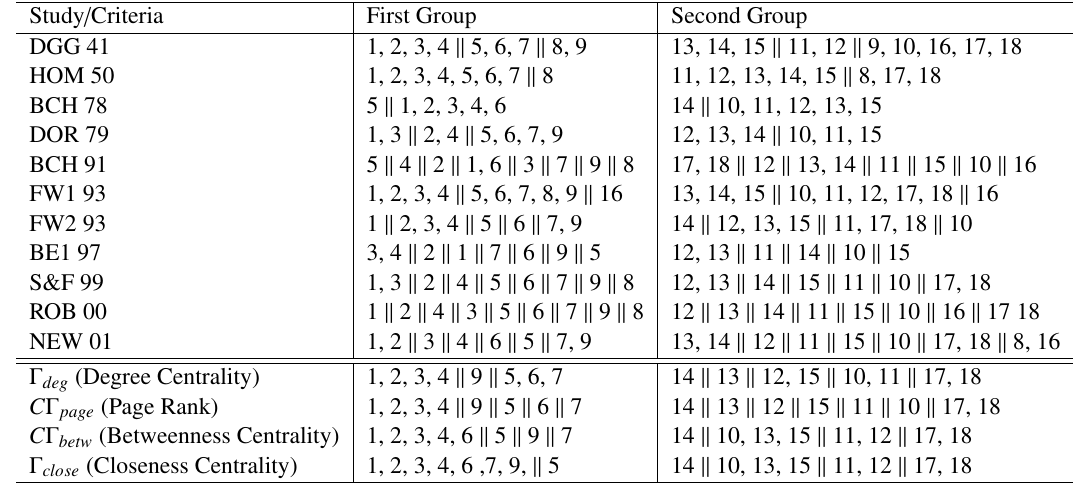
Table 1 The core & periphery membership assignments of the women in the DGG network from 11 di ff erent studies are shown above (see the survey [13]). The rankings are from left to right where di ff erent core and peripheral levels are separated by (cid:107) in each study and the women are represented by their subscripts. The last four rows show the hierarchy obtained for the first and second groups G 1 = { W 1 – W 7 , W 9 } and G 2 = { W 10 – W 15 , W 16 , W 17 } using the four reduction criteria Γ Γ Γ Γ deg , page , betw , and close